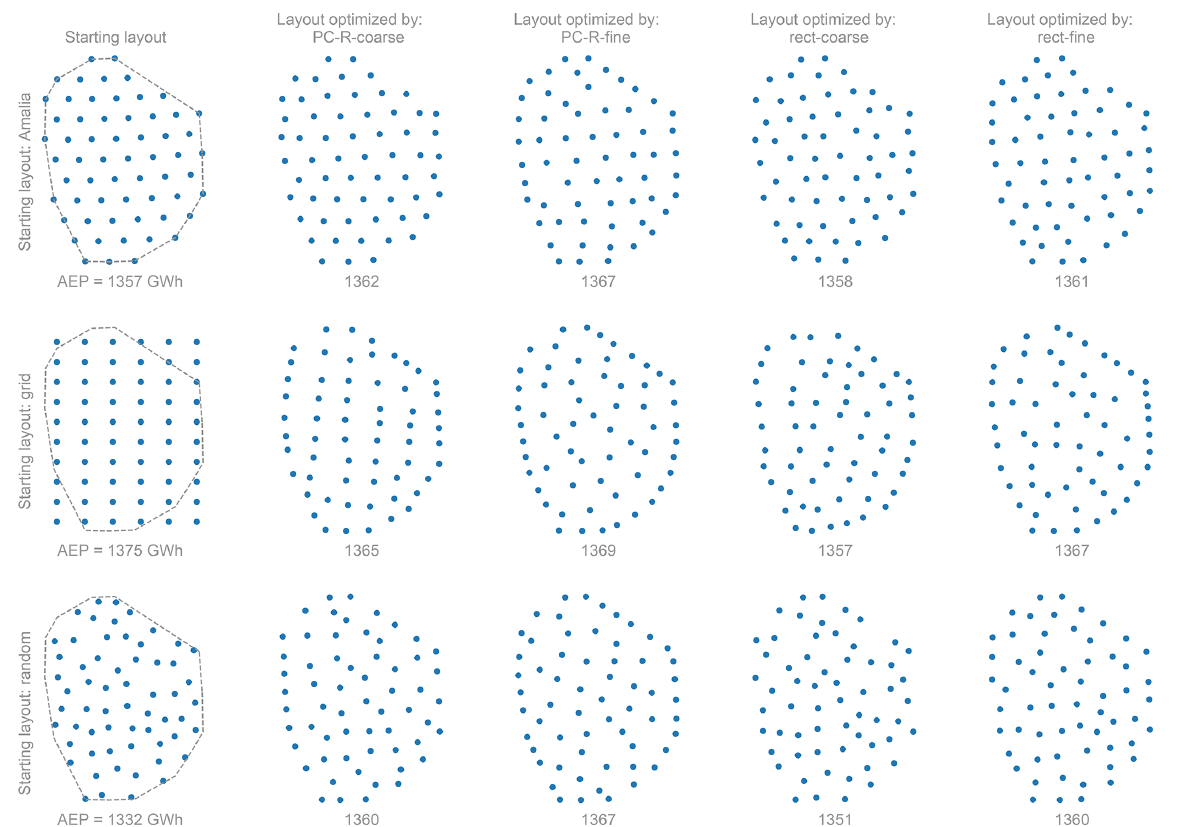
Figure 10. Optimal wind farm layouts achieved for each method to compute the AEP. The layouts in the first column show the turbine starting positions for the optimization along with the boundary constraint (dashed line). The optimal layouts correspond to those with the maximum AEP from Table 2.